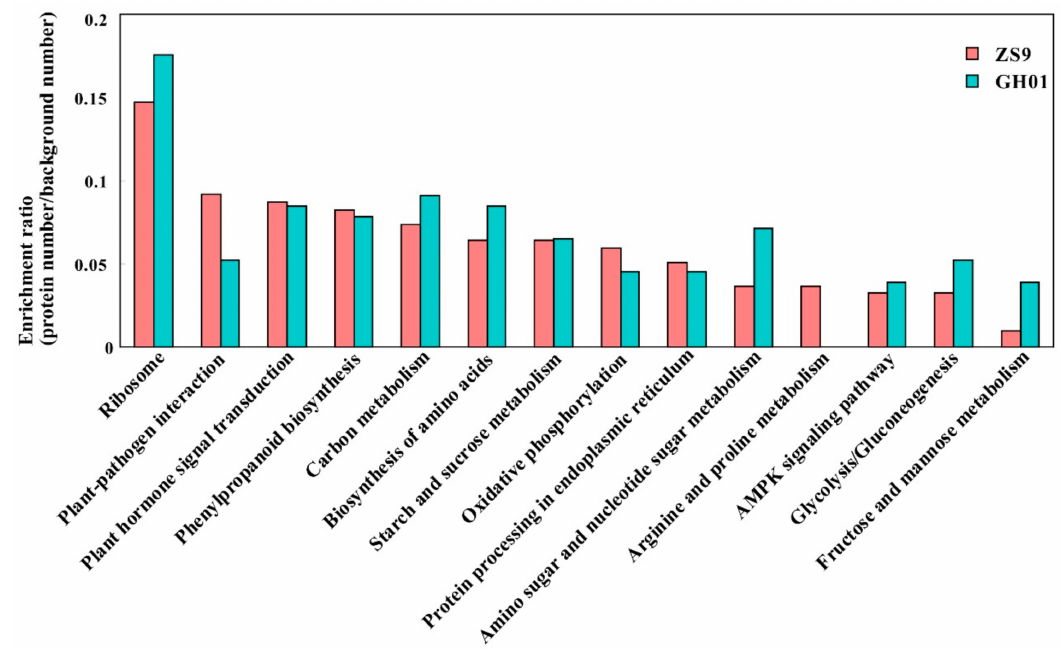
Figure 5. Histogram of significantly enriched proteins in the Kyoto Encyclopedia of Genes and Genomes (KEGG) pathways between ZS9 and GH01. Left y -axis represents the ratio of proteins (protein numbers/background protein numbers) enriched in each